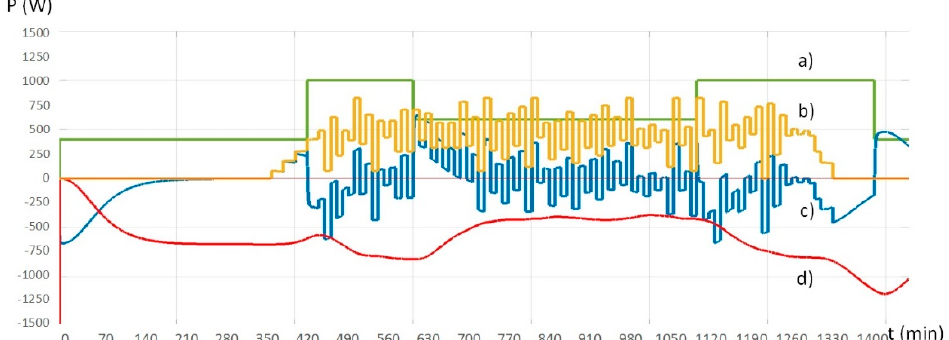
Figure 16. Simulation process for cloudy day conditions. Storage system filter with damping ratio ζ = 0.25: ( a ) the PV plant production, ( b ) the power required by the consumer, ( c ) the battery storage power and ( d ) the supercapacitor power.